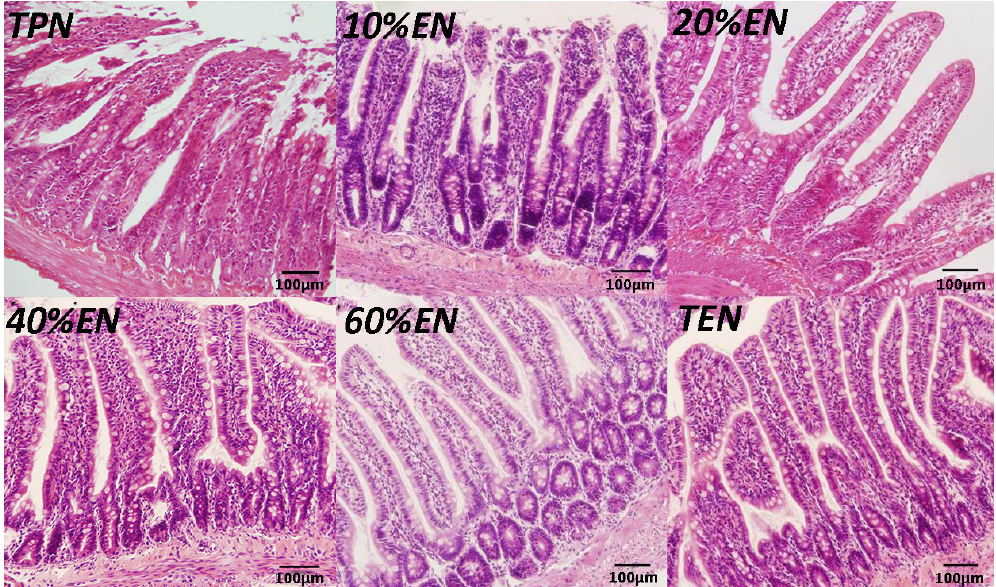
Figure 4. Representative sections of hematoxylin ‐ and ‐ eosin (H&E) staining of the proximal jejunum (×200). There are visible damage (e.g., subepithelial lifting, sloughing, and mucosal edema) in the villi of TPN and 10%EN groups. In the 20% and more EN groups, the rats’ intestinal epithelium had relatively normal histomorphology.